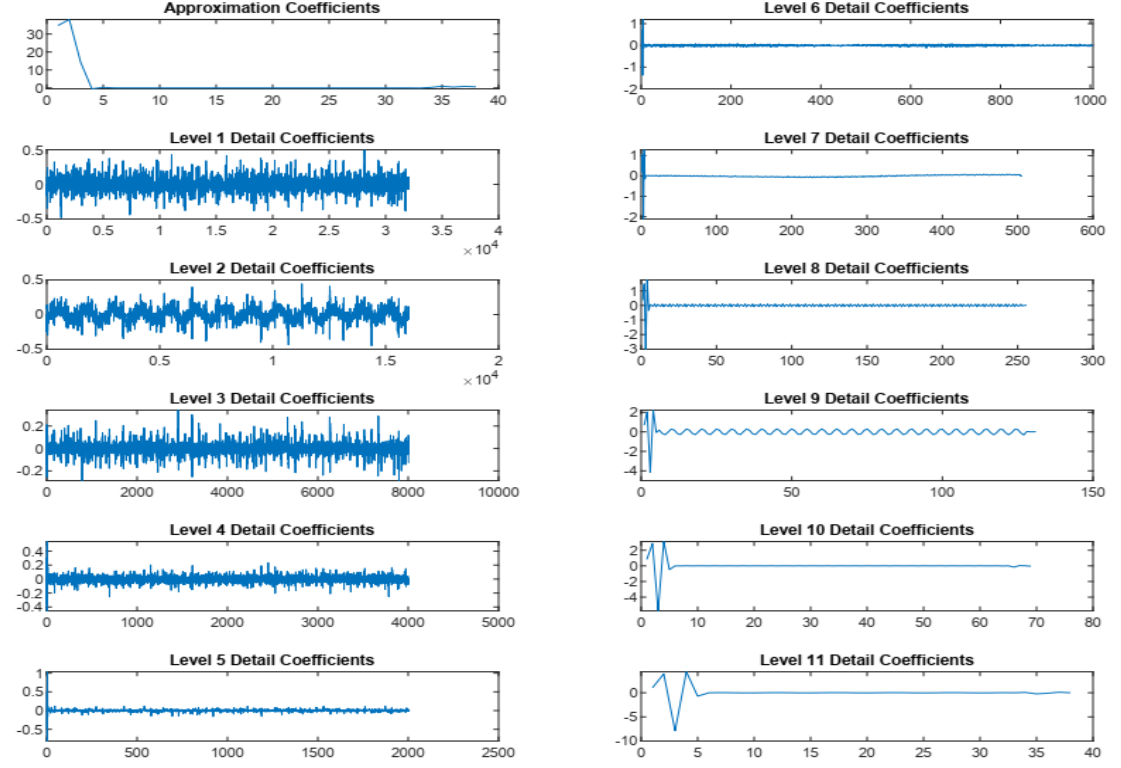
Figure 10. Wavelet decomposition of the ‘sym4′ mother wavelet of the inner fault bearing. Table 3. The formulae used for feature extraction from the current signal (x represents the signal vector). Techniques for Feature Number Extracted Feature